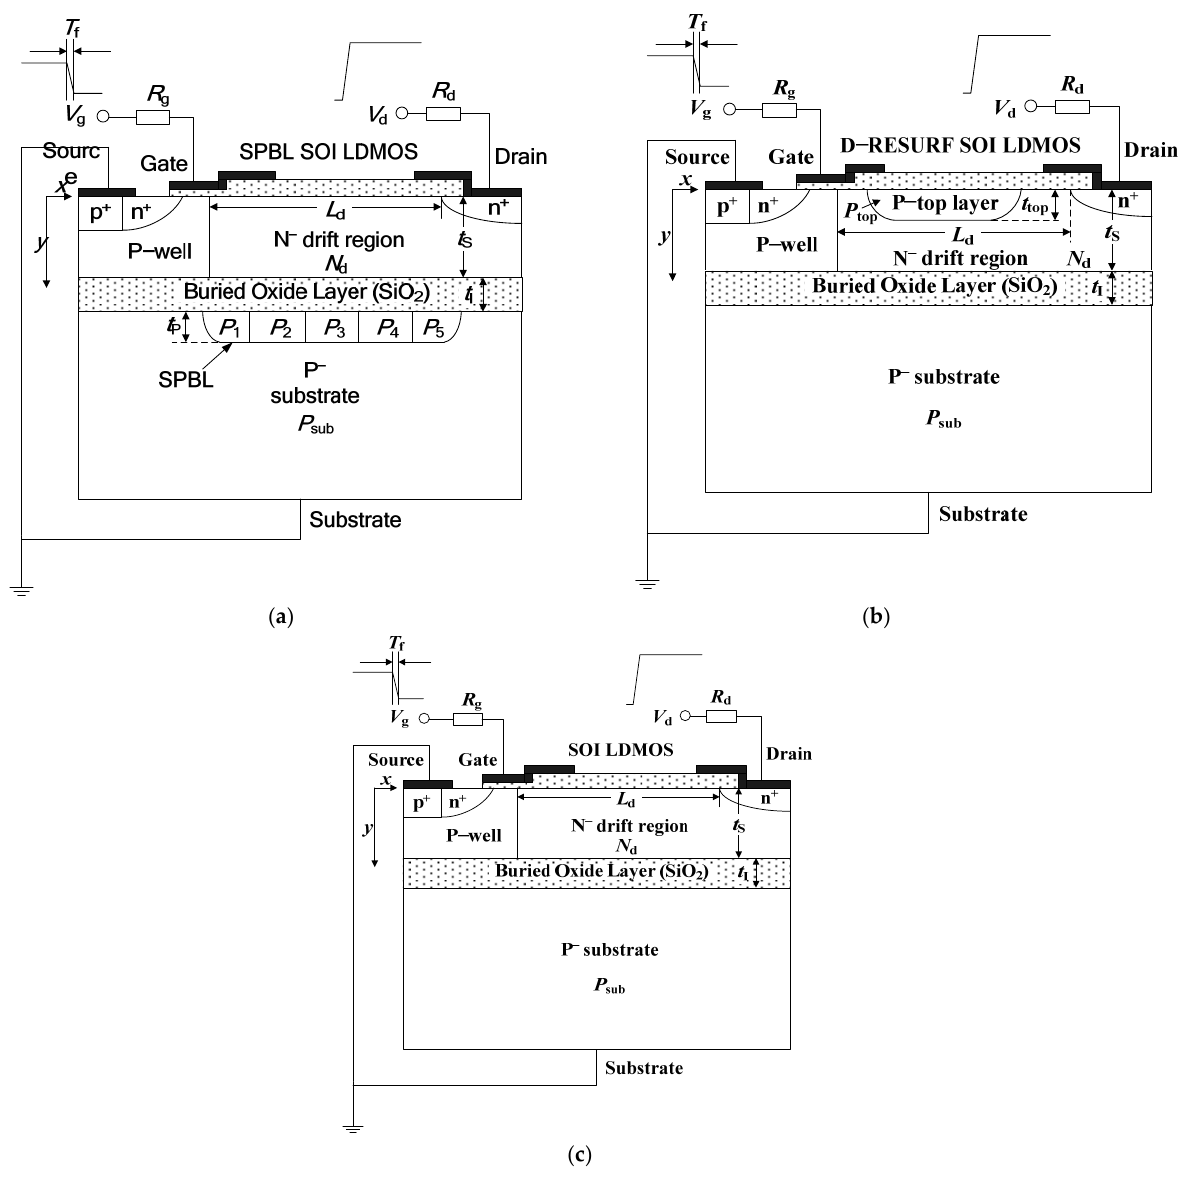
Figure 1. Device structure and simulation circuit of ( a ) SPBL SOI LDMOS, ( b ) D − RESURF SOI LDMOS, and ( c ) SOI LDMOS.